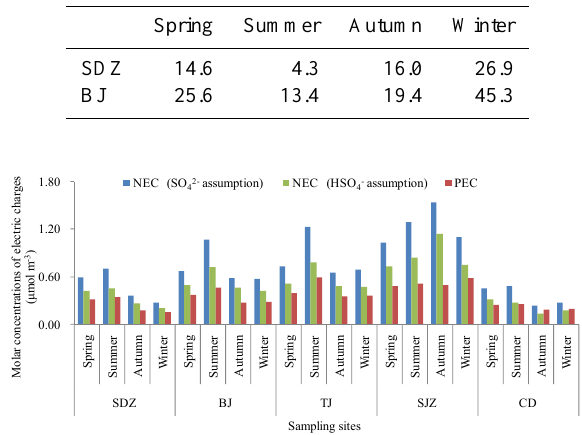
Figure 6. Molar concentrations of positive electric charges of NH 4+ (PEC) and Fig. 6. Molar concentrations of positive electric charges of NH + negative electric charges of NO 3- and SO 42- (NEC). (PEC) and negative electric charges of NO −